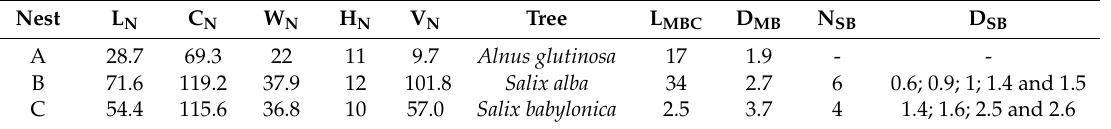
Table 1. External nest structural features. Nest length (L N ), nest circumference (C N ), and nest width (W N ) in centimeters. Volume of the nest (V N ) in liters. The height of the nest (H N ) from the ground (in meters). The number of secondary branches (N SB ), length of the main branch covered by the nest (L MBC ), and the diameter of both the main and secondary branches (D MB and D SB ) in